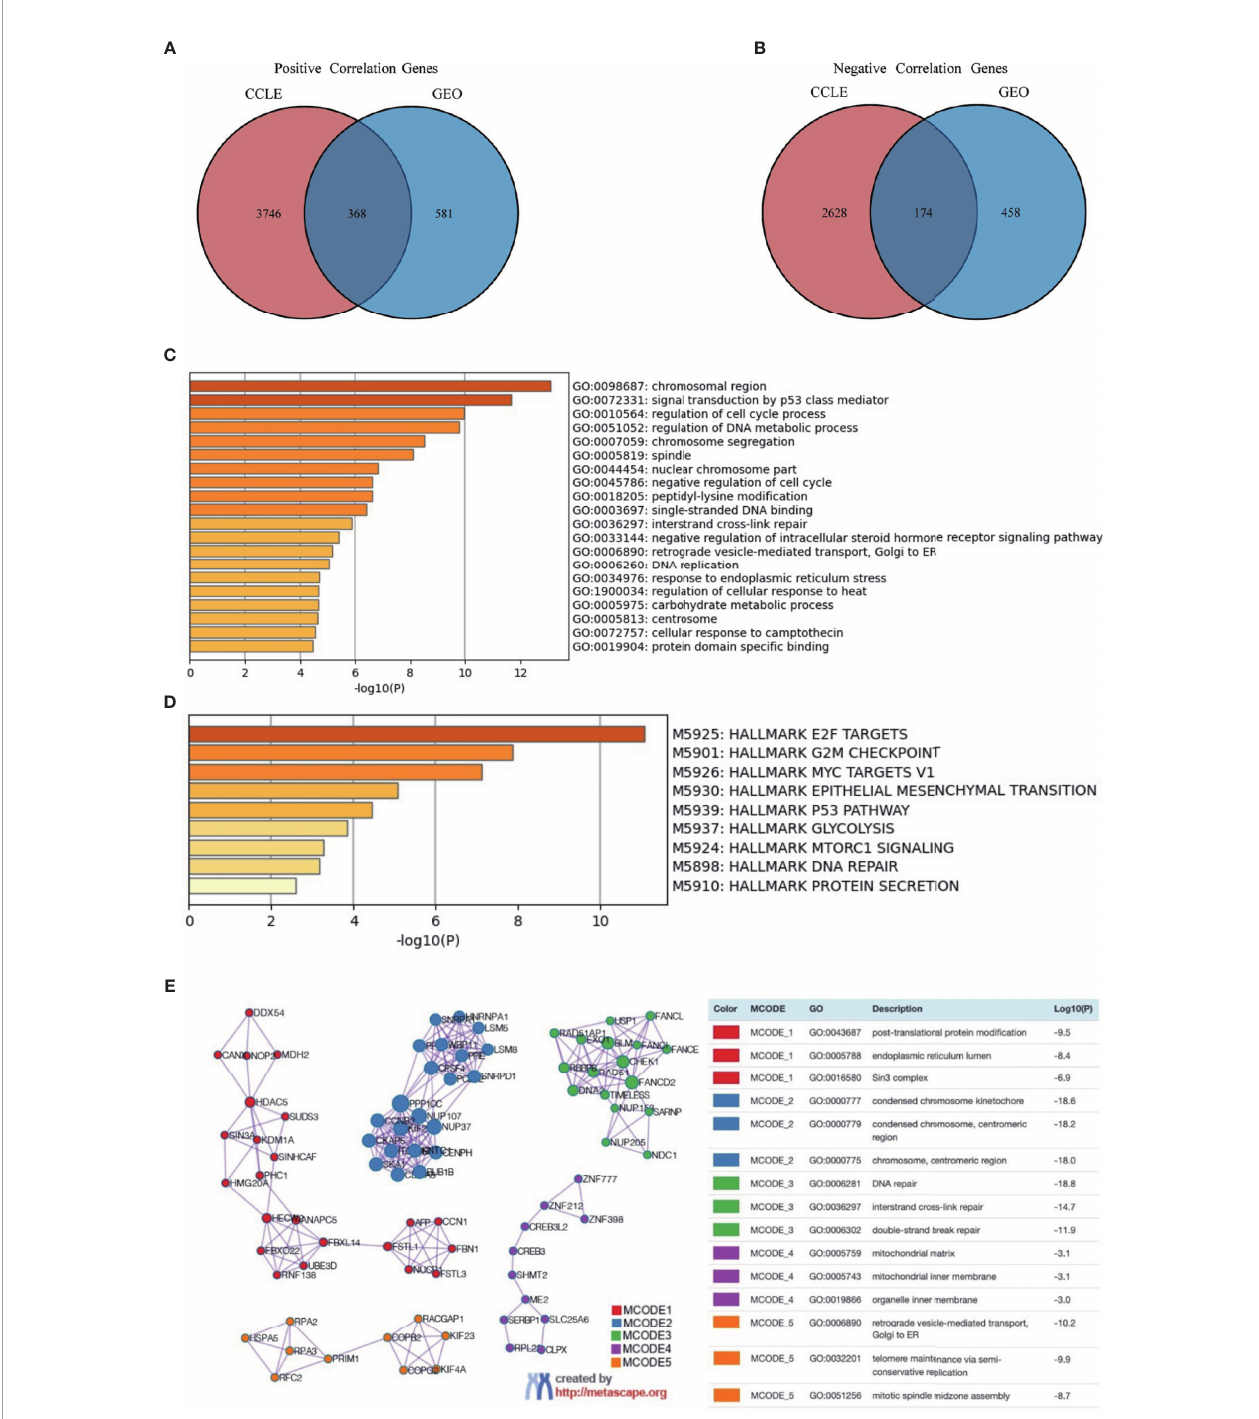
FIGURE 4 | Functional enrichment of FOXP4-AS1-associated genes in ES. (A, B) Spearman correlation revealed that several genes that were had a signi fi cant positive correlation while others had a negative correlation with FOXP4-AS1 across datasets from both GEO and CCLE databases. The intersection of these genes is shown in the Venn diagrams. (C, D) Metascape was used for GO, and Hallmark Gene Sets enrichment analysis of signi fi cant correlation genes. (E) Metascape was used to construct a PPI network. The top fi ve MCODE components were abstracted from the PPI network, then subjected to GO enrichment